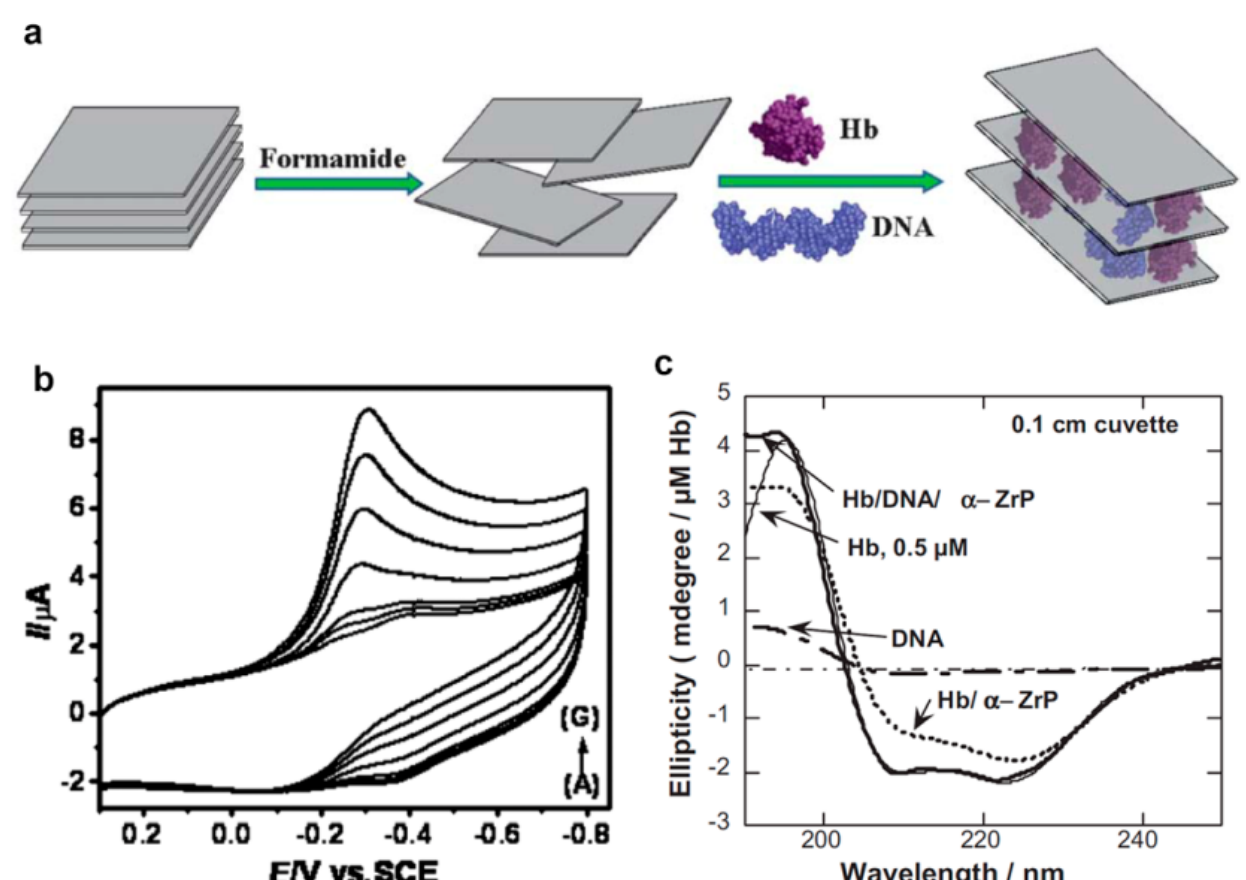
Figure 5. A scheme of co-intercalation of hemoglobin and DNA into the LDH interlayers ( a ) and cyclic voltammograms of Hb/DNA/LDH electrode incubated in a buffer with increasing H 2 O 2 concentrations from (A) to (G), where (A) = 0, (B) = 0.97, (C) = 9.71, (D) = 48.52, (E) = 97.05, (F) = 145.58, (G) = 194.1 µM H 2 O 2 ( b ) Reproduced with permission from [150] Copyright 2013 Royal Society of Chemistry. Circular dichroism spectra of Hb (thin line), DNA (dashed line) and Hb bound to α -ZrP in the presence (thick line) or absence of (dotted line) DNA ( c ). Reproduced with permission from [151]. Copyright 2006 John Wiley and Sons.